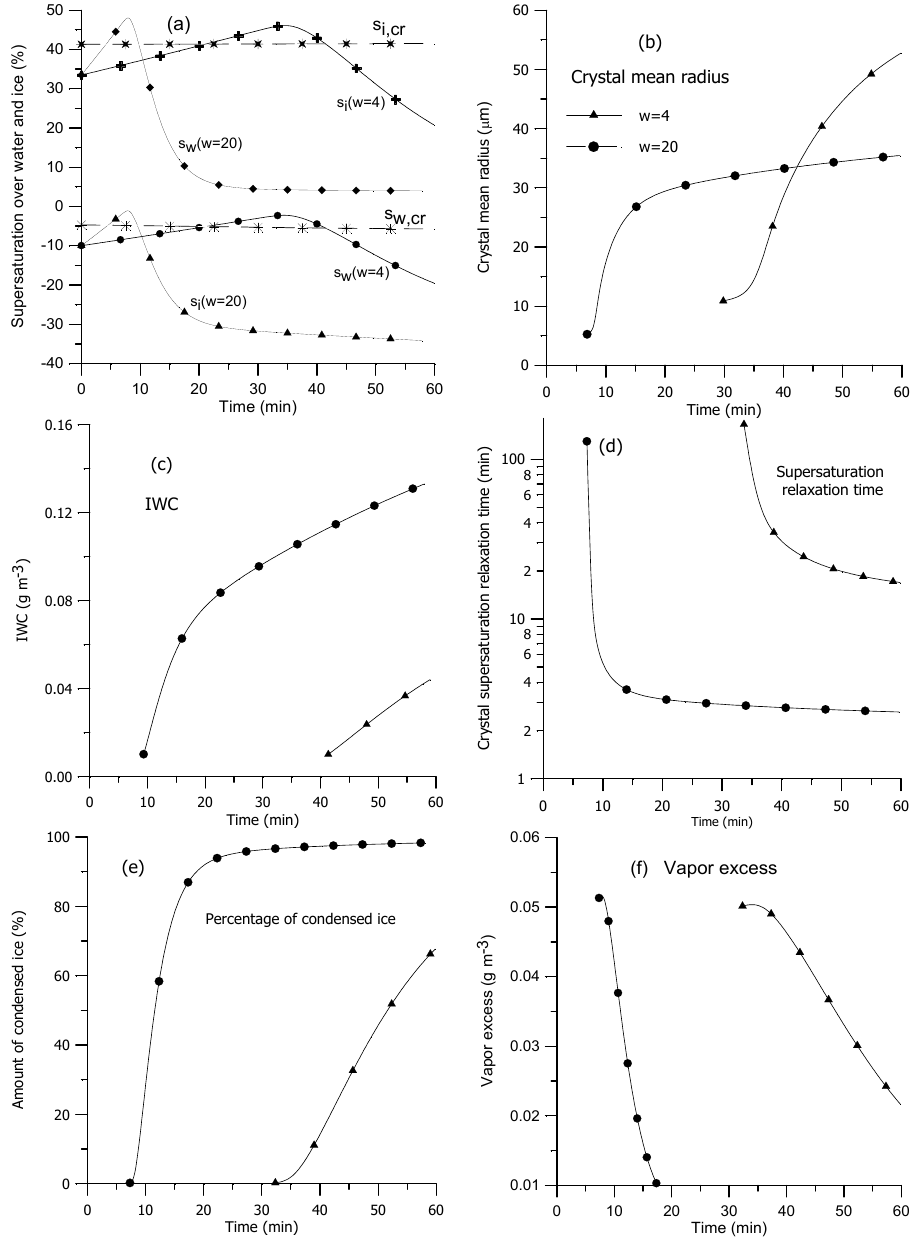
(b) crystal mean radius, µ m; (c) ice water content, g m -3 ; (d) crystal supersaturation relaxation time, min; (e) relative amount of condensed ice, %; (f) vapor excess, mg m -3 .